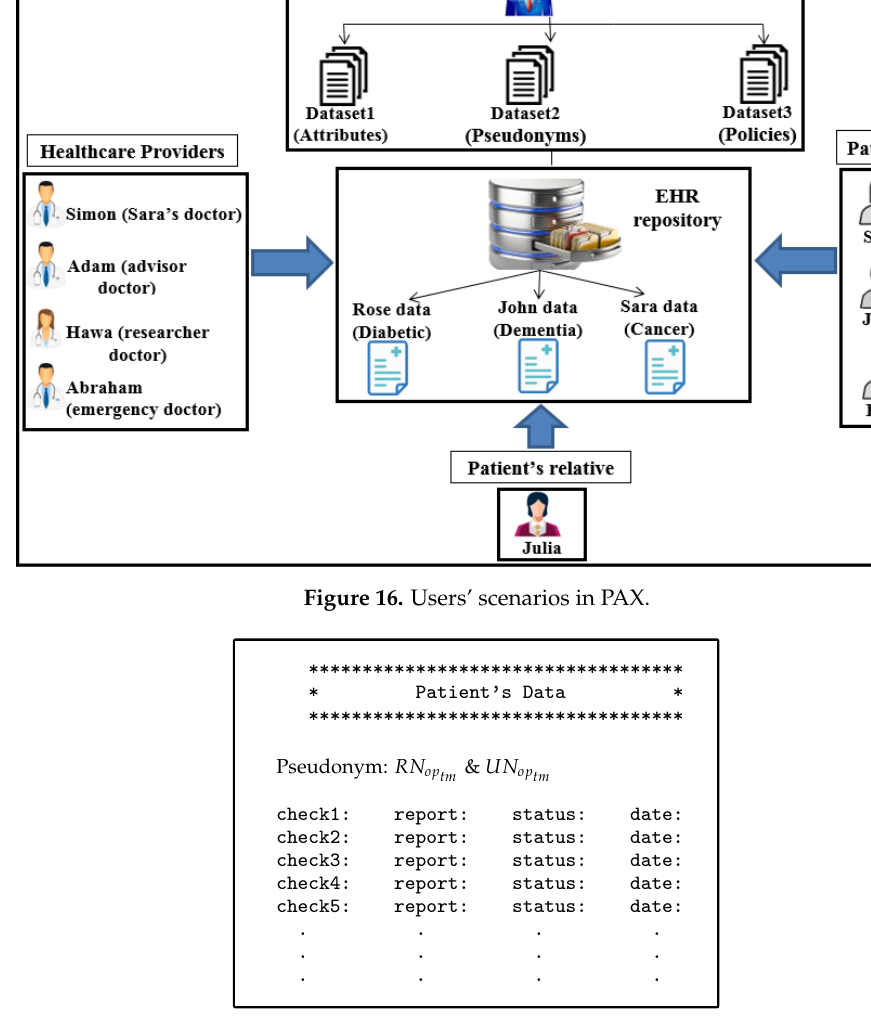
Figure 17. Part of Sarah’s Figure 16. Part of Sarah’s data. Figure 17. Part of medical records